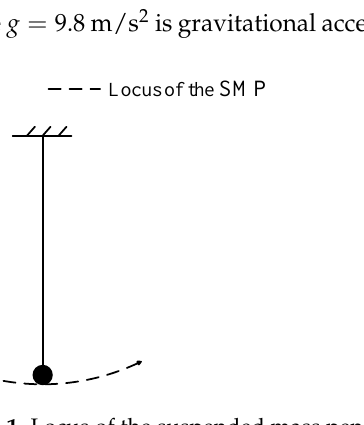
Figure 1. Locus of the suspended mass pendulum.